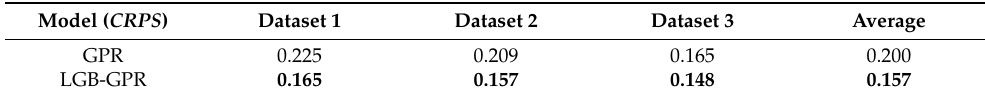
Table 6. CRPS score results statistics